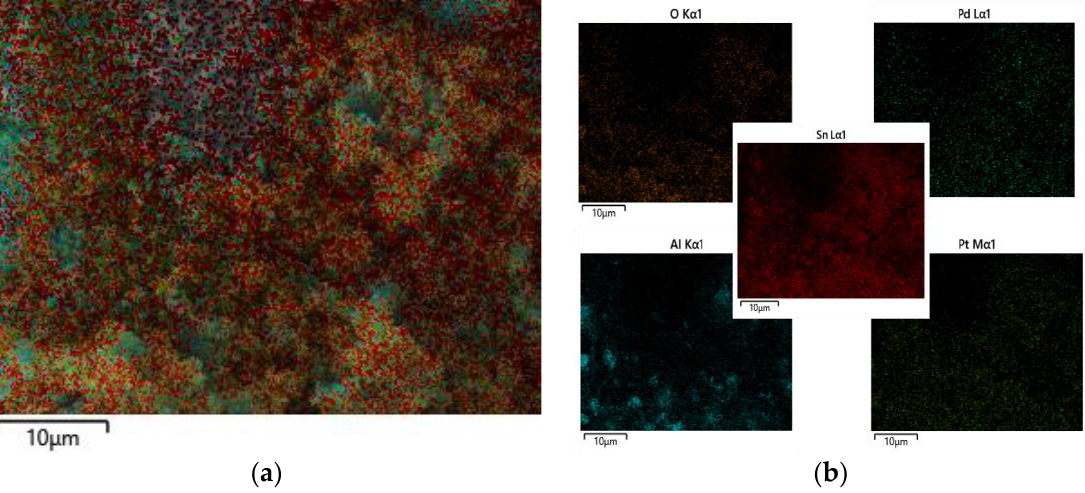
Figure 2. SEM characterization of sensitive films: ( a ) the Pd – Pt/SnO 2 thin film; and ( b ) the Pd – Pt/SnO 2 /Al 2 O 3 thin film.